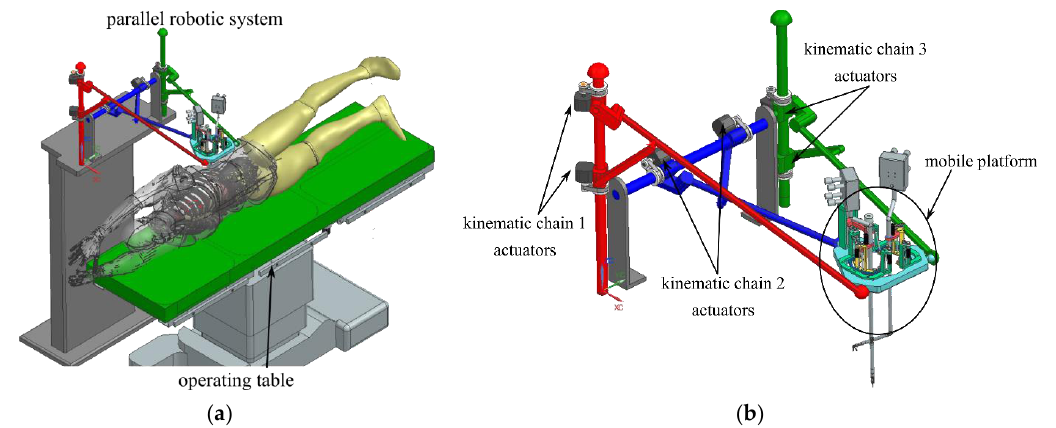
Figure 17. CAD model of the optimized version of the parallel robotic system for SILS: ( a ) relative position between the robotic system and the patient; ( b ) the 6-DOF parallel robotic system for SILS.